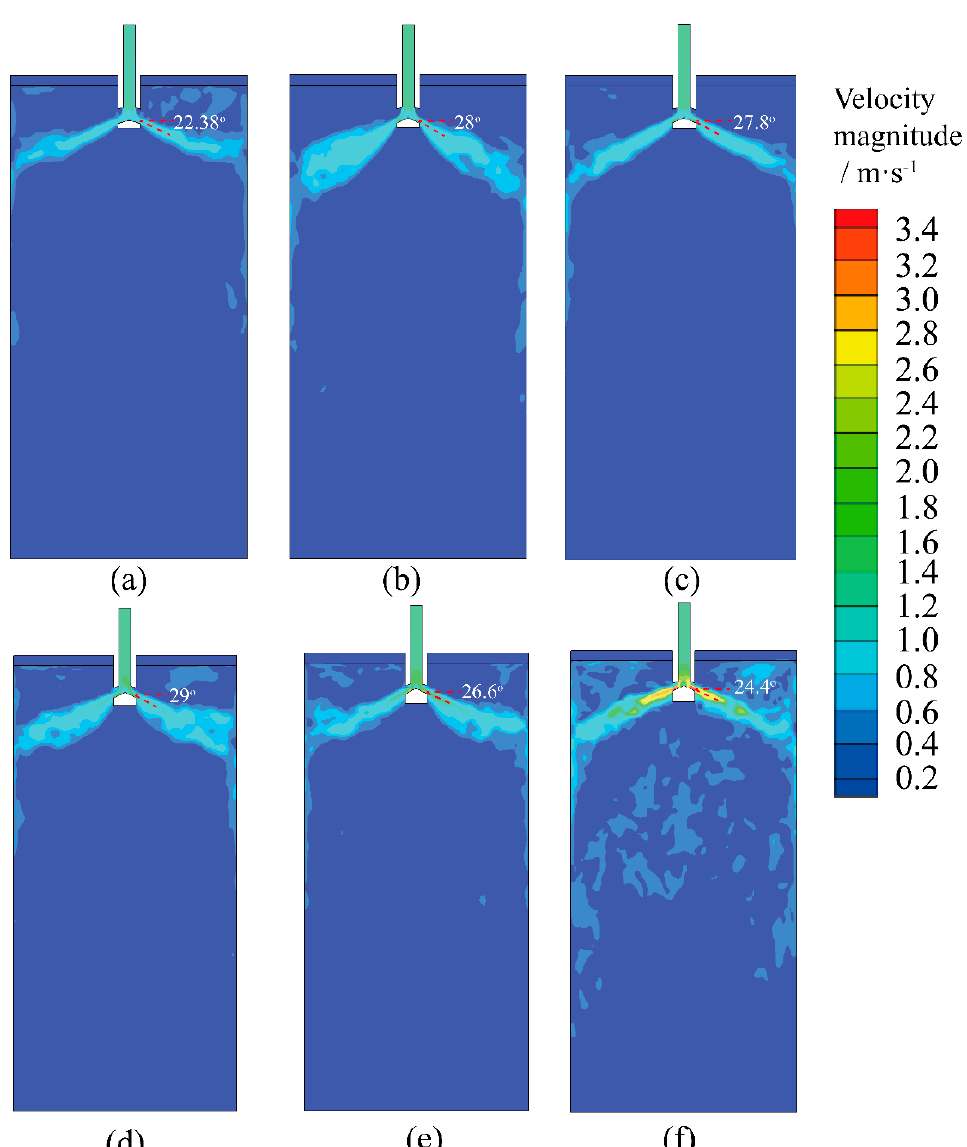
Figure 6. The contour of transient-velocity magnitude in z = 0 plane under different block rates. ( a ) Non-clog, ( b ) 10.32%, ( c ) 23.05%, ( d ) 38.17%, ( e ) 41.34%, ( f ) 45.9% (solution time at 38.5 s).